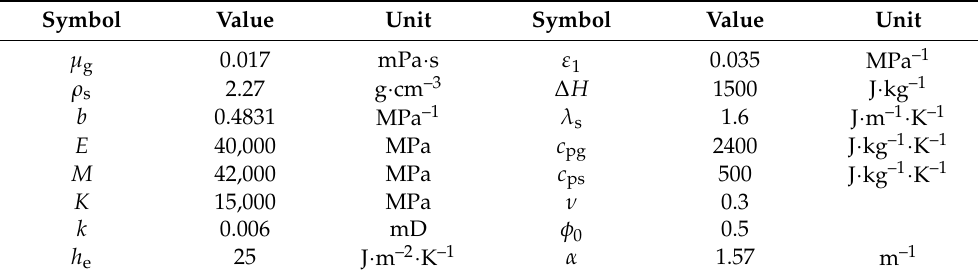
Table 1. Relevant parameters used during mathematical modeling.